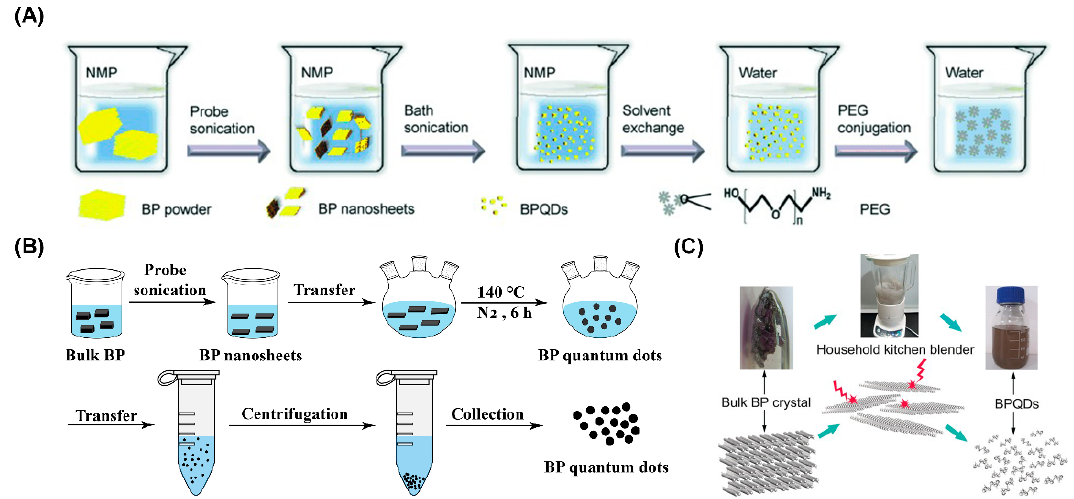
Figure 3. Synthesis routes of BPQDs based on ( A ) ultrasonic exfoliation method (Reproduced with permission from Sun et al., Angew. Chem. Int. Ed. Engl.; published by WILEY, 2015 [57]), ( B ) the solvothermal method, and ( C ) blender break- ing method (Reproduced with permission from Zhu et al., Chemistry; published by WILEY, 2016 [61]).